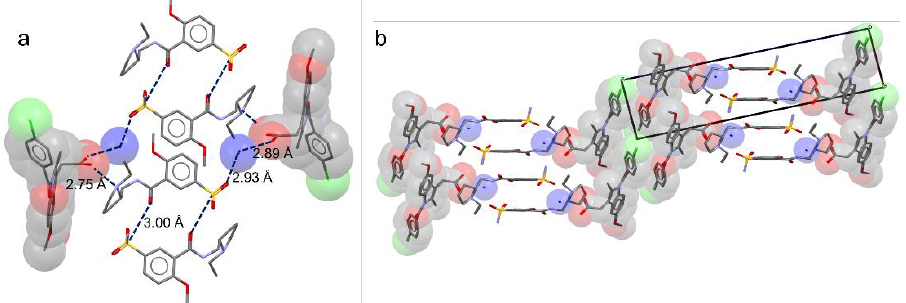
Figure 6. ( a ) Intermolecular interactions established between IND anions and the hydrogenated SULP molecules (dashed blue lines). Homomeric interaction between SULP dimers are also reported. ESDs are omitted for the sake of clarity. ( b ) Crystal packing of SULP-IND along (010) direction. Color code C = grey, N = blue, O = red, S = yellow, Cl = green. IND ions are highlighted with spacefill style shadow. Hydration water molecules are highlighted with blue spacefill style shadow. Hydrogen atoms are omitted for the sake of clarity.